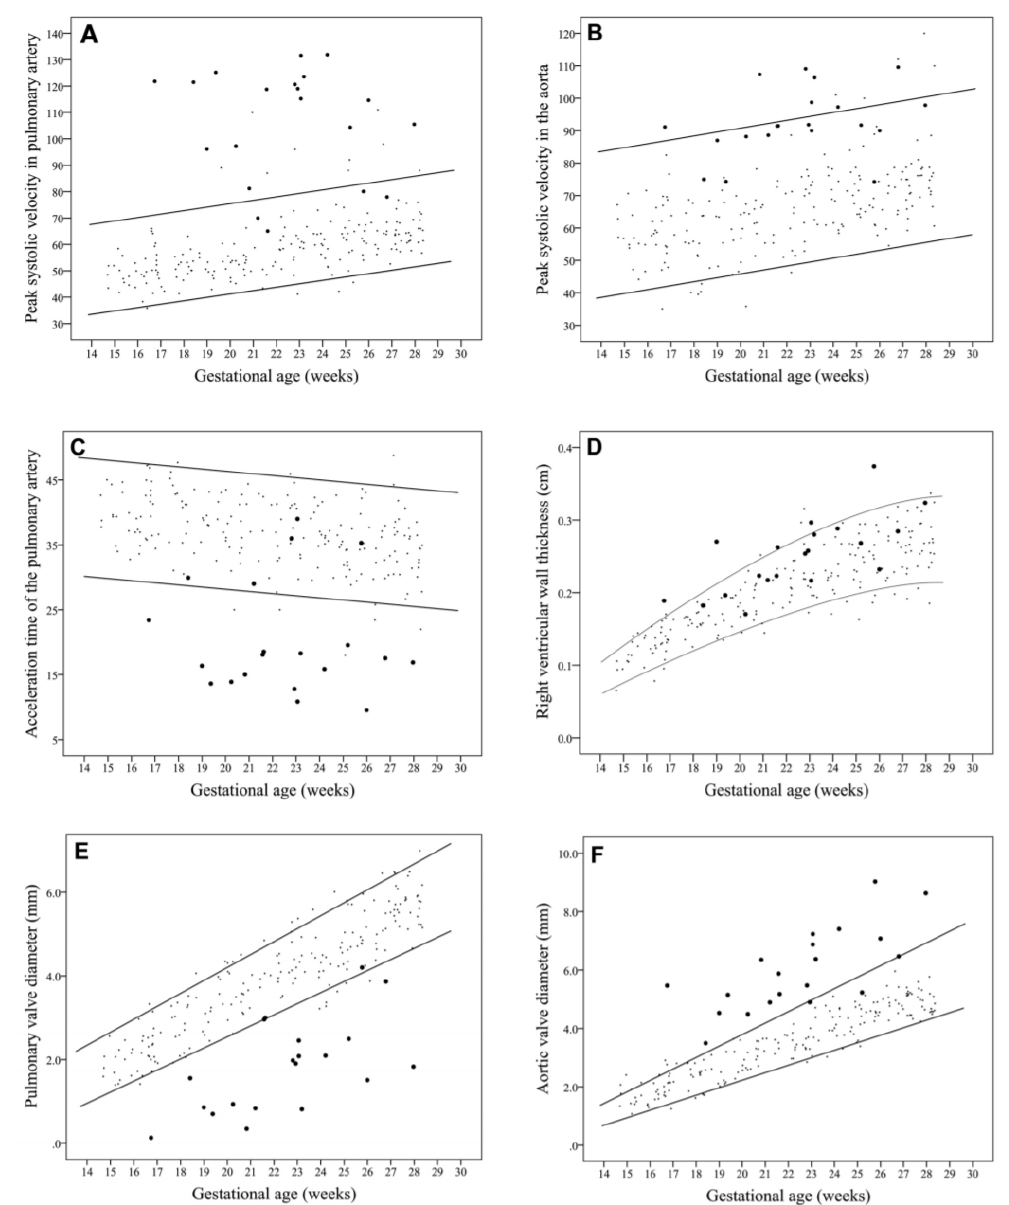
Figure 4. Comparison of absolute values of cardiac parameters measured using echocardiography at various gestational ages among healthy fetuses (small dots) and fetuses with TOF (large dots). Lines represent the 5th and 95th percentiles of normal reference ranges. ( A ) Peak systolic velocity in pulmonary artery; ( B ) Peak systolic velocity in the aorta; ( C ) Acceleration time of the pulmonary artery; ( D ) Right ventricular wall thickness; ( E ) Pulmonary valve diameter; ( F ) Aortic valve diameter. Reproduced with permission from